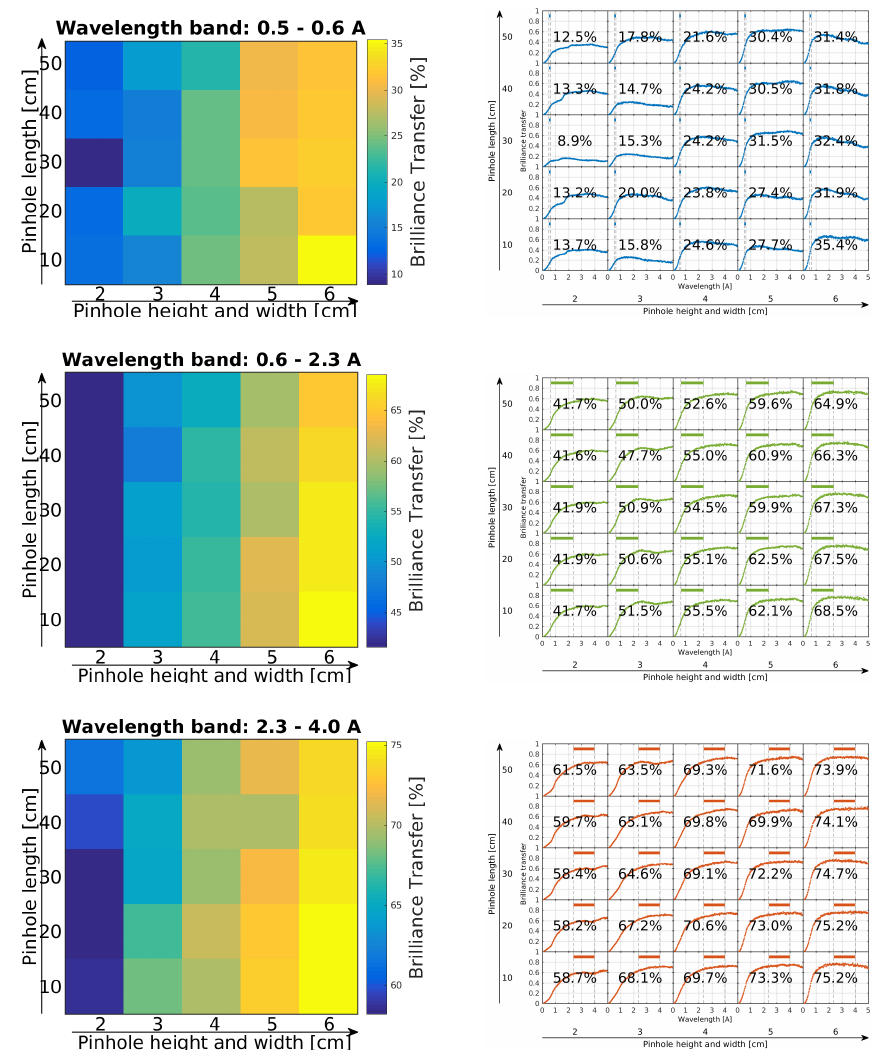
Figure A1. Left panels: Average values of BT , given as a color code. Both graphs are shown for 5 values of quadratic pinhole size (horizontal displacement) and 5 values of pinhole length (vertical displacement). Right panels: Simulated values of BT as a function of neutron wavelength (in the range 0–5 Å) for guides optimized for 0.5–0.6 Å (blue curves), 0.6–2.3 Å (green curves), and 2.3–4.0 Å (red curves). The number on each graph displays the average BT value within the relevant wavelength